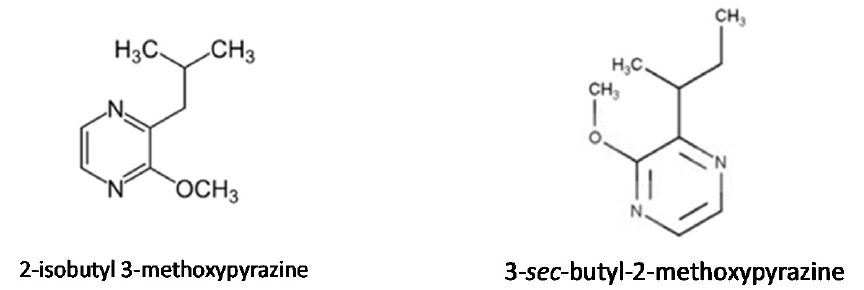
Figure 13 . Chemical structure of 3-butylphthalide.